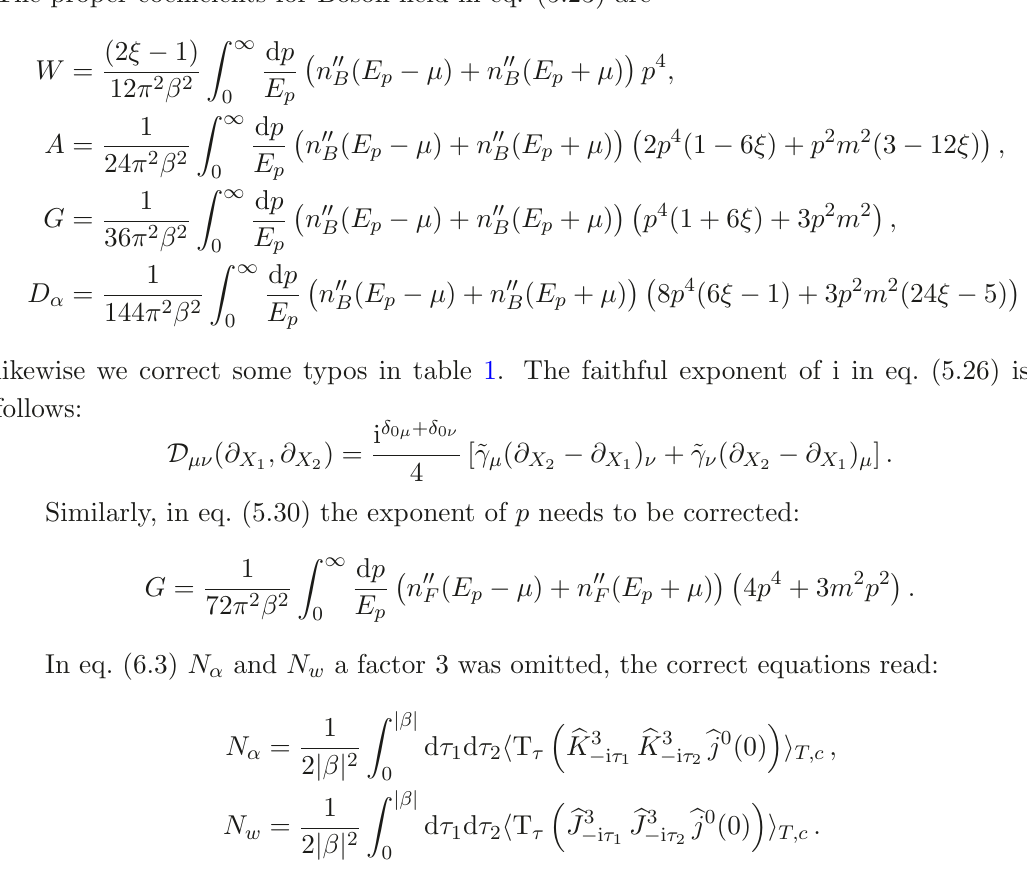
Table 1 . The stress-energy tensor coefficients (5.3) for a free Boson field: the first column reports the coefficients in the massless case with µ = 0, the second column reports the n th term of the expansion (8.2), the third column reports the asymptotic expansion at low temperature (8.3). Our result for W in the massless case agrees with that obtained in ref. [29] for λ 3 (see eq. (9.1)). The proper coefficients for Boson field in eq. (5.23)